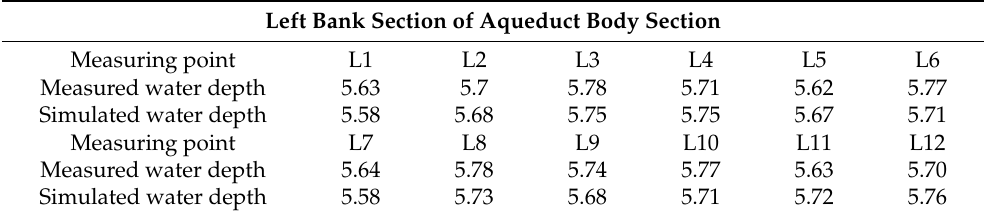
Table 2. Comparison between measured water depth and simulated water depth on the left bank of the aqueduct. Left Bank Section of Aqueduct Body Section